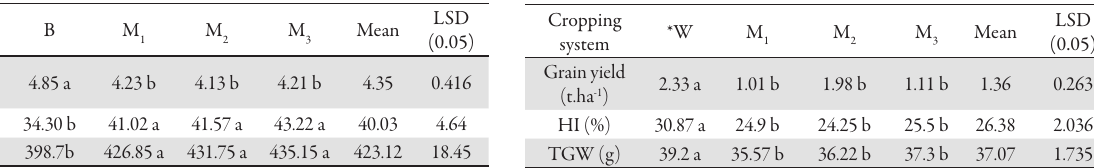
Tab. 5. Effect of different cropping system on bean grain yield, harvest index (HI) and thousand grain weight (TGW)